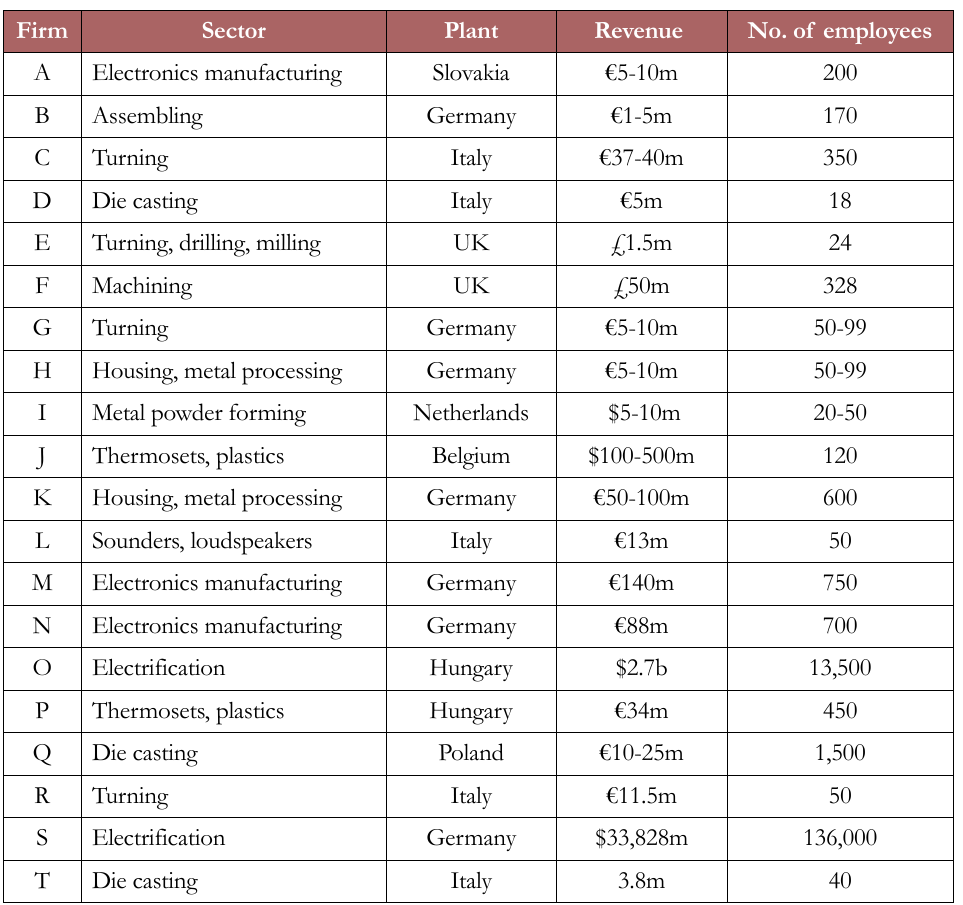
Table 1. Characteristics of interviewed firms, case